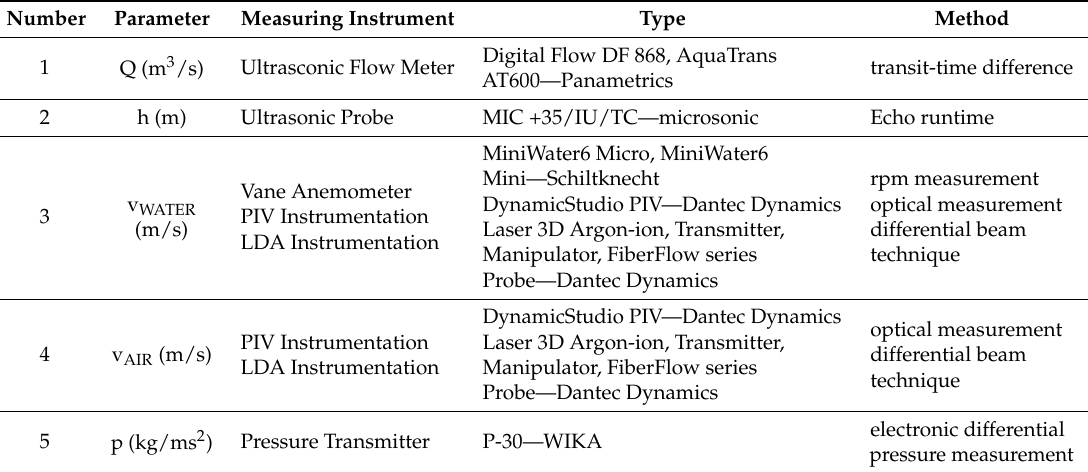
Table 1. Measurement